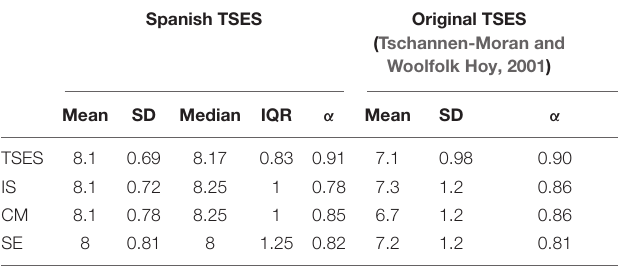
TABLE 3 | Descriptive statistics and reliability for the Spanish and original versions of the TSES. Spanish TSES